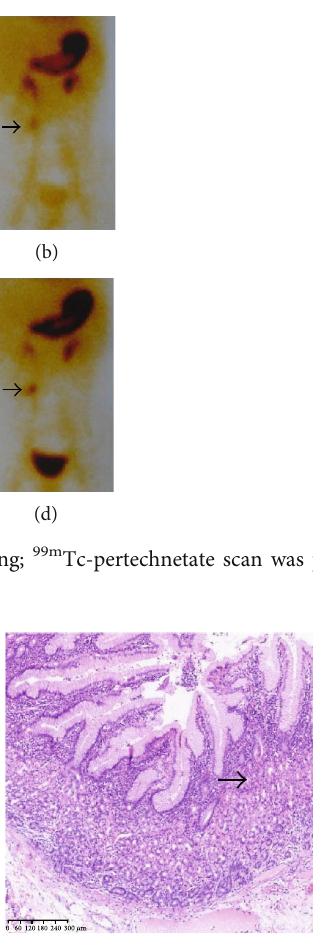
Figure 2: Ectopic gastric mucosa was found in Meckel ’ s diverticulum; the arrows show the ectopic gastric